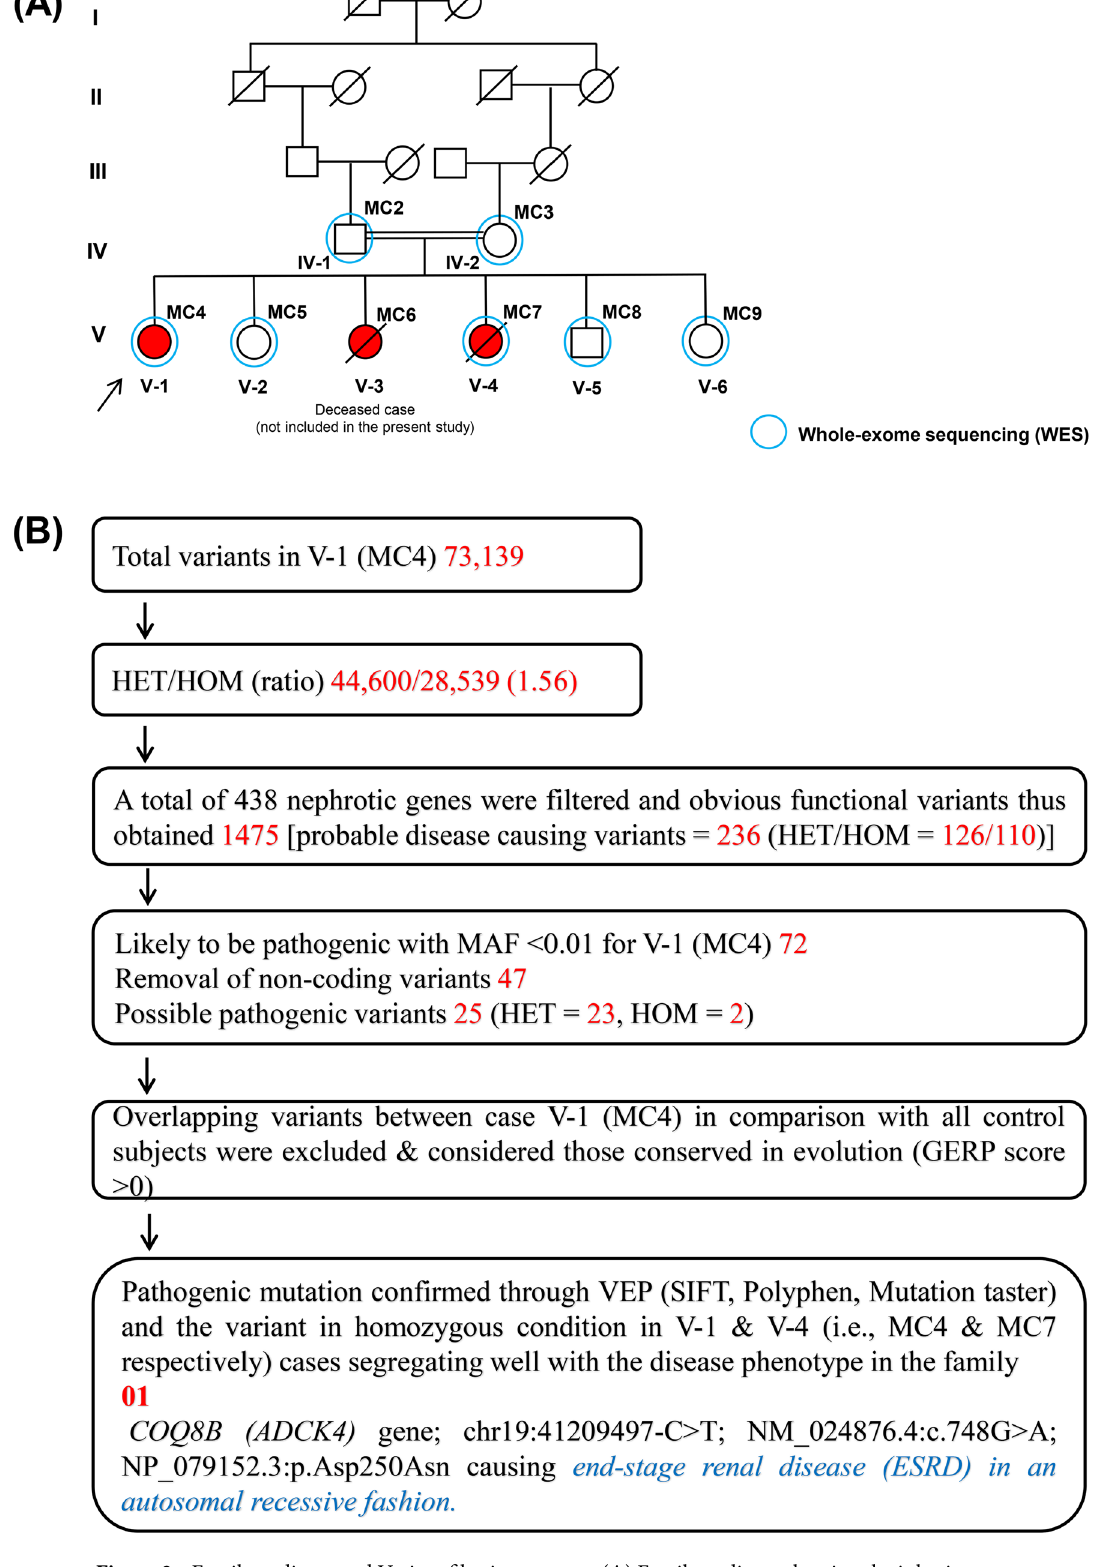
Figure 2. Family pedigree and Variant filtering strategy. ( A ) Family pedigree showing the inheritance pattern of nephrotic syndrome. Cases are shown in red color, and blue circles represent the subjects undergone WES ( B ) Variant filtering strategy. A narrowing down approach to identify the most promising causative